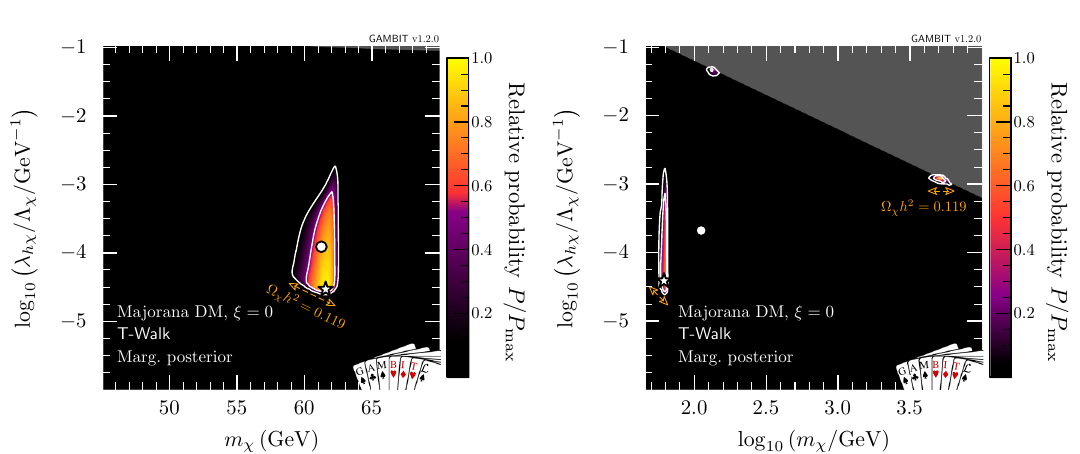
Fig. 12 MarginalisedposteriordistributionsforMajoranafermionDM with fixed ξ = 0. Contour lines show the 1 and 2 σ credible regions. The left panel gives the result of a scan restricted to the resonance region around m χ ∼ m h / 2. The right panel shows a full-range param-